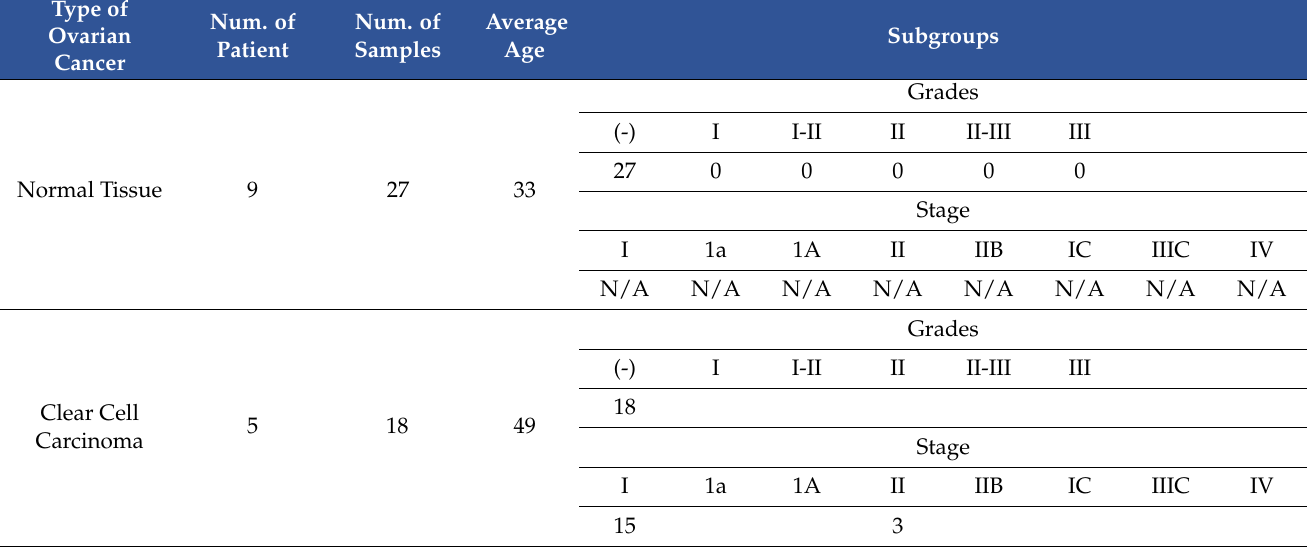
Table 1. Tissue array sample composition and